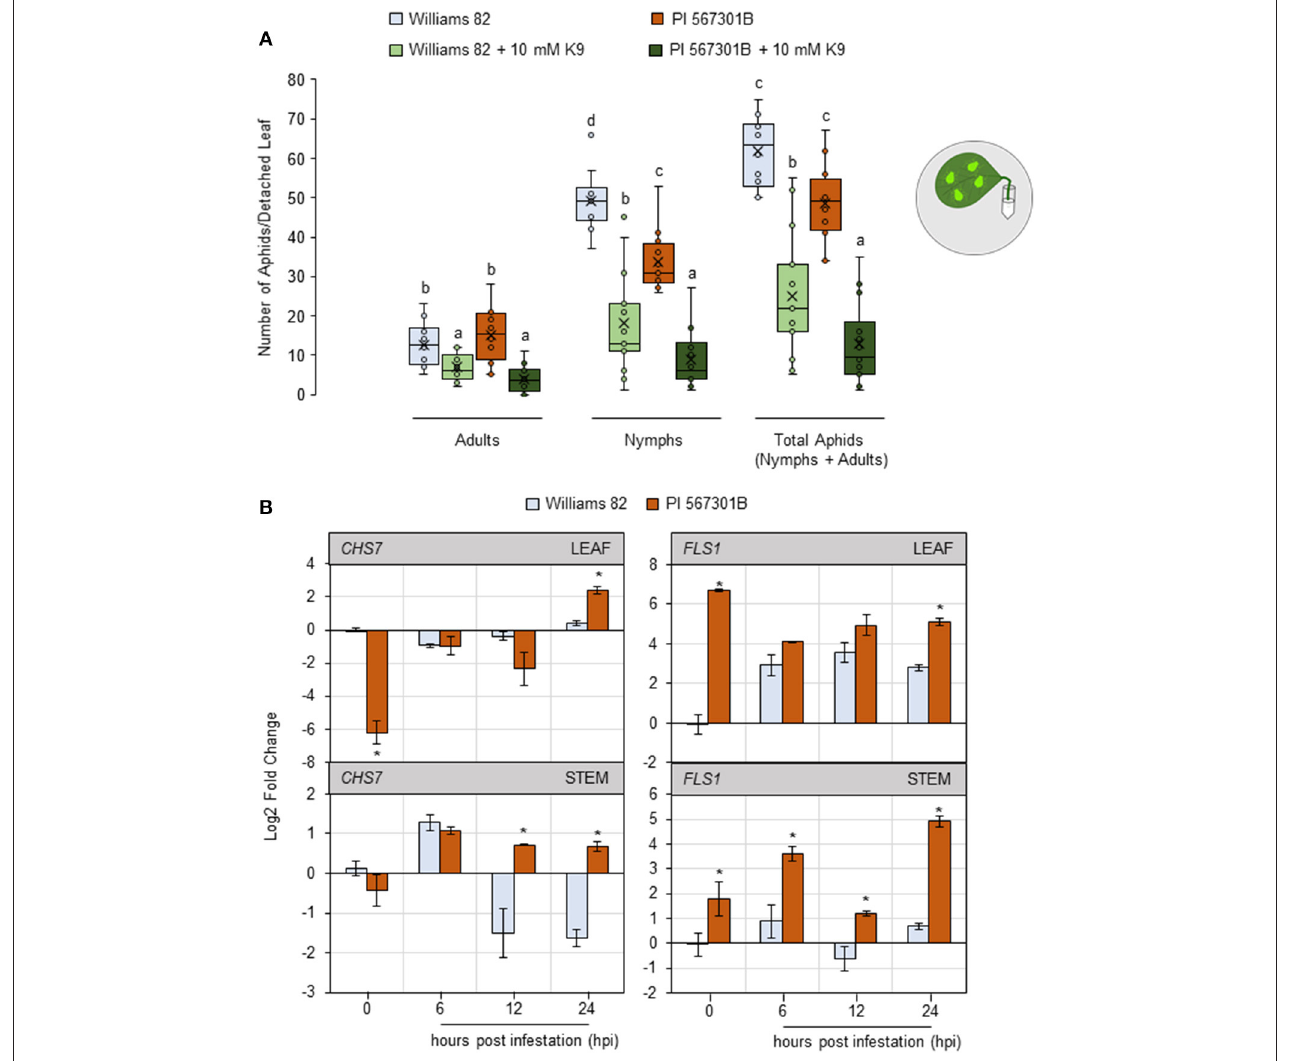
FIGURE 4 | Kaempferol may play a role in Rag5- mediated resistance to soybean aphids. (A) Populations of soybean aphids on detached leaf assays supplemented with kaempferol-9-glycoside (K9). The numbers of adults and nymphs are recorded daily for 4 days, and data for day 4 are shown. The values are mean ± standard error of mean ( n = 12). Different letters above the bars indicate values that are significantly different from each other ( P < 0.05; GLM/ANOVA). Three replications are performed for each genotype and treatment combination, and the experiment is repeated three times. The cartoon represents the setup for the detached leaf assay. Aphid size and number in the cartoons are not drawn to scale. (B) Quantitative real-time reverse transcribed PCR (RT-qPCR) to determine the expression of kaempferol biosynthesis genes, chalcone synthase 7 ( CHS7 , Glyma01g228700), and flavanol synthase 1 ( FLS1 , Glyma13g082300) in leaf and stem tissue of Williams 82 and PI 567301B in a time course experiment. The comparative C T method is used to calculate fold change, and all samples are compared with Williams 82 0h (uninfested samples). Data are presented as log2-fold change, and the error bars represent standard deviation ( n = 4). Asterisks above the bars indicate statistically significant differences ( P < 0.05; t